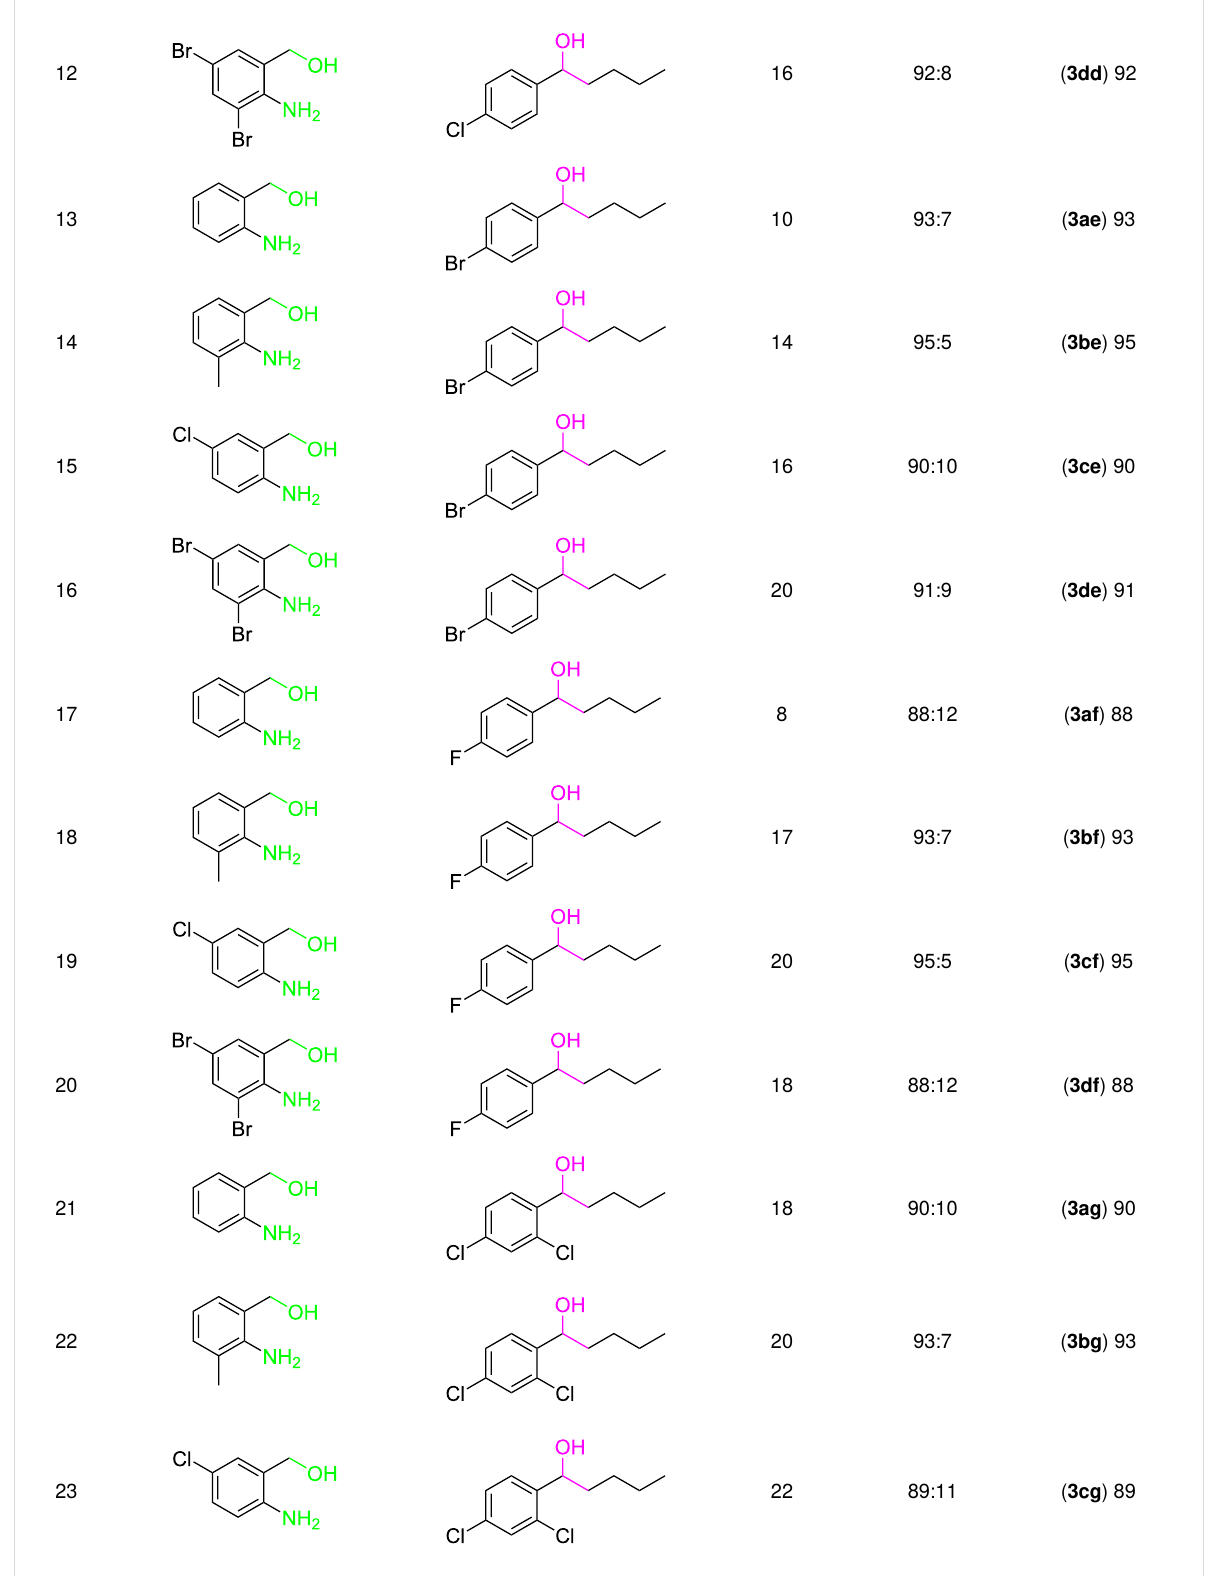
Table 3: Cyclometalated iridium-catalyzed ADC reaction of various 2-aminobenzyl alcohols and secondary alcohols. a